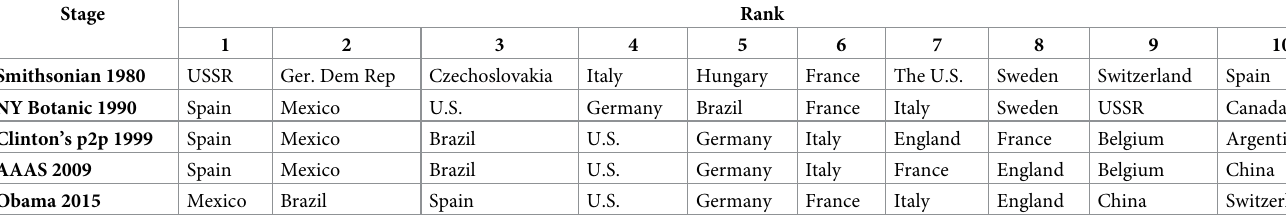
Table 5. The top ten countries in the Cuban academic international collaborative